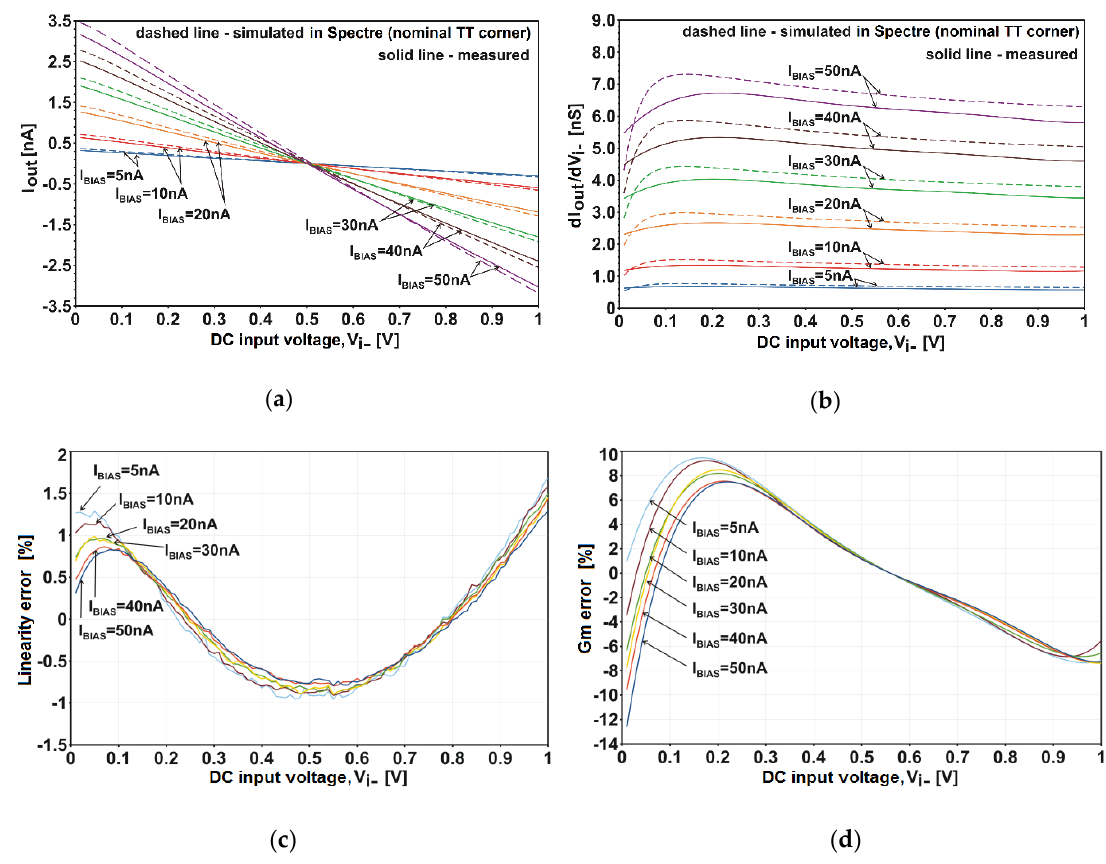
Figure 5. DC characteristics of the amplifier from Figure 3 at asymmetrical drive: ( a ) I out vs. V i − ; ( b ) derivatives d I out / d V i − ; ( c ) linearity error of the measured I out vs. V i − plots; ( d ) deviation error of the measured d I out / d V i − plots (i.e., deviation error of G m ). The V i + is fixed at 0.5 V, V DD is 1 V and temperature is 27 °C.